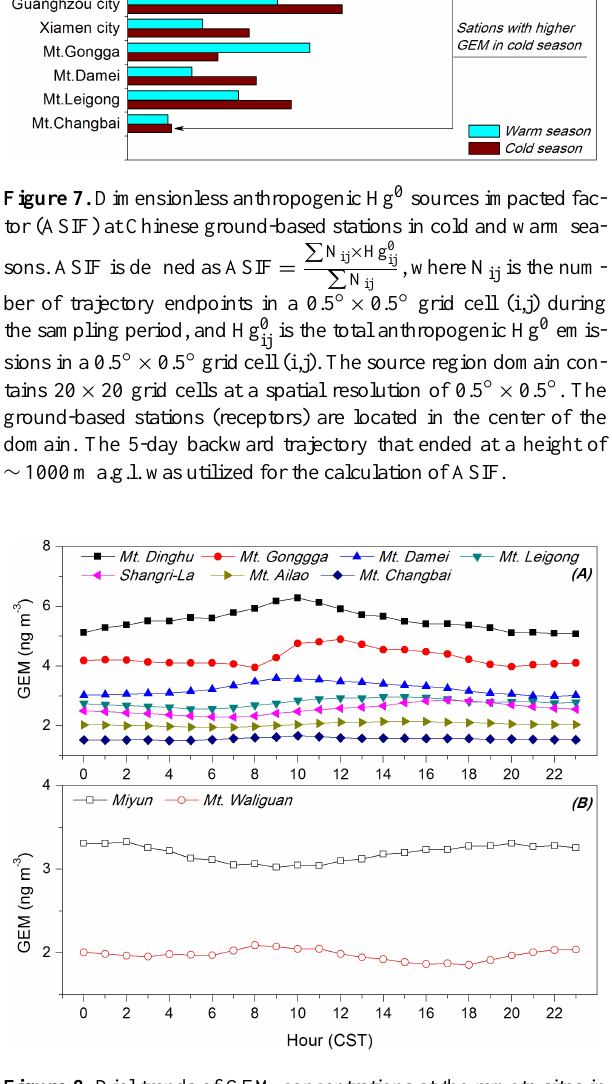
Figure 8. Diel trends of GEM concentrations at the remote sites in China. The diel trends at the remote sites in China were calculated on the basis of at least 1 year of continuous measurements (the time schedule for each of the sites was shown in Table 1).